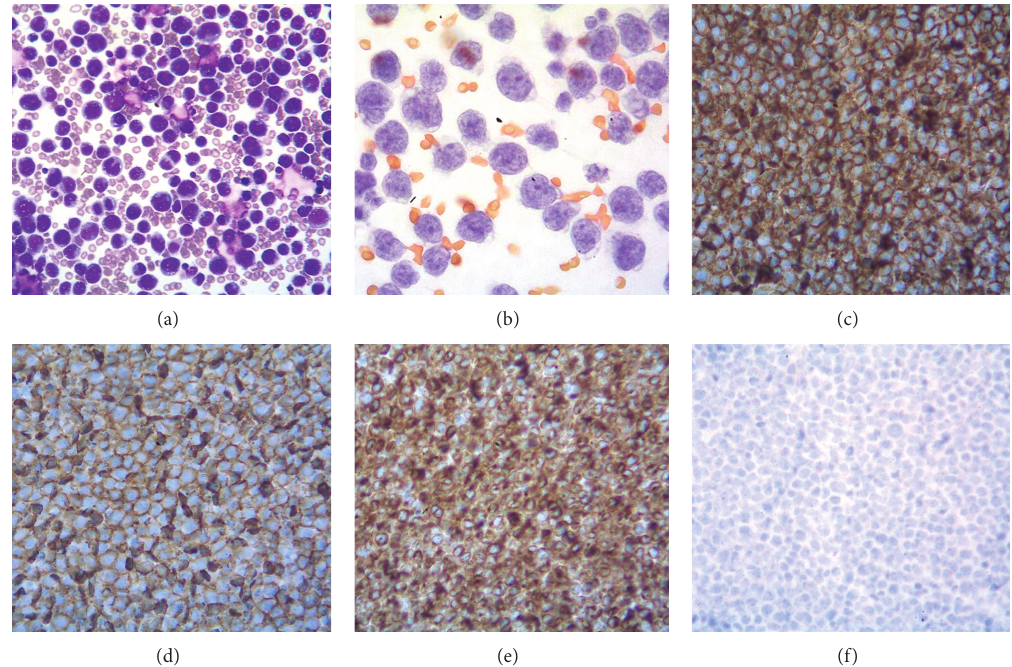
F 1: Cytological analysis revealed large atypical lymphoid cells with irregular nuclei, prominent nucleoli and basophilic vacuolated cytoplasm ((a), May-Grünwald-Giemsa; (b), Papanicolaou). By immunohistochemistry of a corresponding cell block specimen, the large cells were strongly positive for CD45 (c), CD20 (d), and CD79a (e), and were negative for CD138 (f), indicative of a mature B-cell